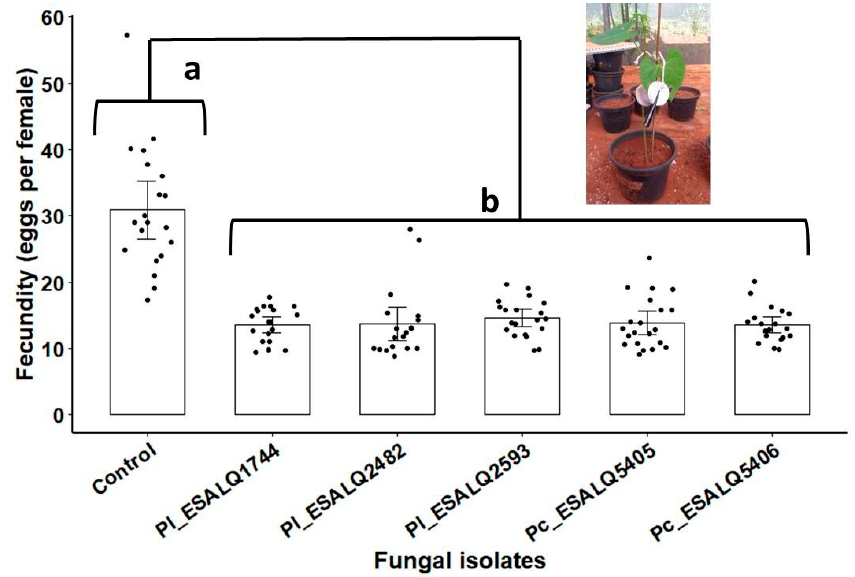
Figure 5. The number of eggs laid by Tetranychus urticae after seven days of infestation in bean plants derived from seeds inoculated with six different treatments: fungus-free control (0.5% w / v of Arabic gum) and fungal treatments based on seed-coating with MS (dose equivalent 10 12 conidia ha − 1 ) of the isolates ESALQ1744, ESALQ2482 and ESALQ2593 of Purpureocillium lilacinum (Pl), and isolates ESALQ5405 and ESALQ5406 of Pochonia chlamydosporia (Pc). Means (± 95% confidence interval, n = 20 biological replicates from two independent experiments) of spider mite counts (eggs per leaf arena). Treatments (vertical bars) followed by distinct letters differ significantly at p < 0.05 based on Tukey HSD. 3.6. Effects of Nematophagous Fungi on the Population Growth of H. glycines Two independent greenhouse trials were carried out to assess the impact of isolates of two nematophagous fungal species against H. glycines in potted bean plants. Since these two experiments were conducted at different periods of the year, they greatly varied in terms of temperature, relative humidity, and photoperiod, and also exhibited a significant difference in magnitude between trials regarding the final nematode population in untreated plants (Trial 1: 507 nematodes versus Trial 2: 142 nematodes). Regarding the H. glycines final population, there was a significant effect in decreasing the nematode numbers displayed by isolates P. chlamydosporia ESALQ5406 and P. lilacinum ESALQ2593 when compared to control plants infested only with H. glycines in the first ( χ 2 = 12.75, df = 5, p = 0.0258) and the second trial ( χ 2 = 15.34, df = 5, p = 0.0090) (Figure 6). Consistently, these two nematophagous fungal isolates significantly reduced the final nematode population by approximately 2-fold and 3.5-fold compared to untreated plants infested with H. glycines , respectively. The other fungal isolates did not have a meaningful effect on the reduction of the final nematode population. Interestingly, bean plants treated with the isolate P. lilacinum ESALQ1744 portrayed a similar trend to that found in untreated plants. Actually, untreated plants had an increase in population growth of H. glycines , while P. lilacinum ESALQ1744 was unsuccessful in reducing nematode reproduction in both trials.